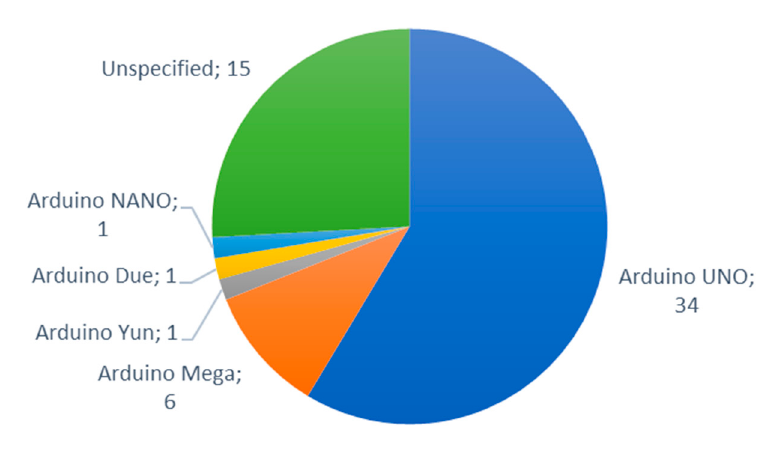
Figure 22. Arduino nodes utilized to implement IoT irrigation systems.